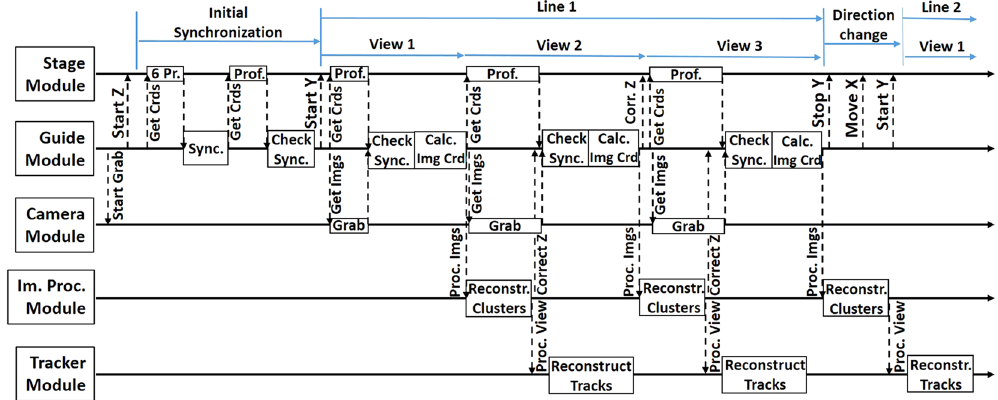
Figure 4. Workflow diagram for the CM technique. Thick solid horizontal arrows indicate the execution flow. Thin dashed vertical arrows indicate commands flow directed from client module to server module that executes it. Rectangular boxes represent operations requested.